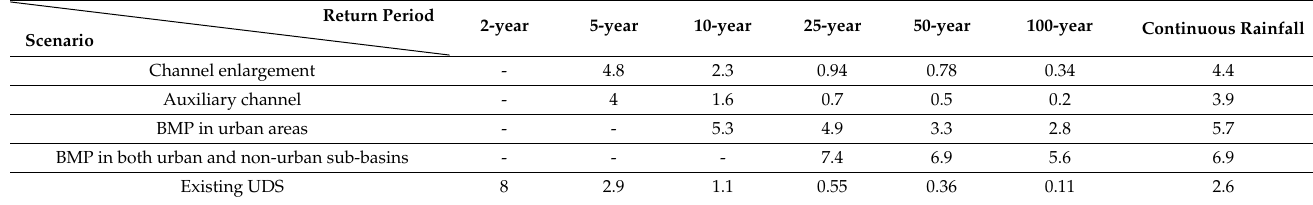
Table 5. Braking capacity ( BrC ) for various scenarios (mm/min).